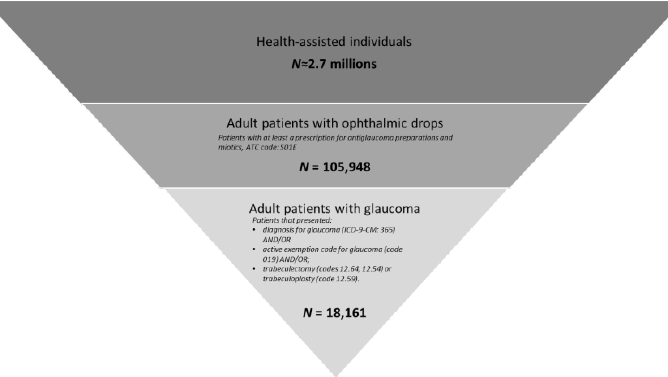
Figure 1. Flow-chart of the included patients based on the methodology applied.